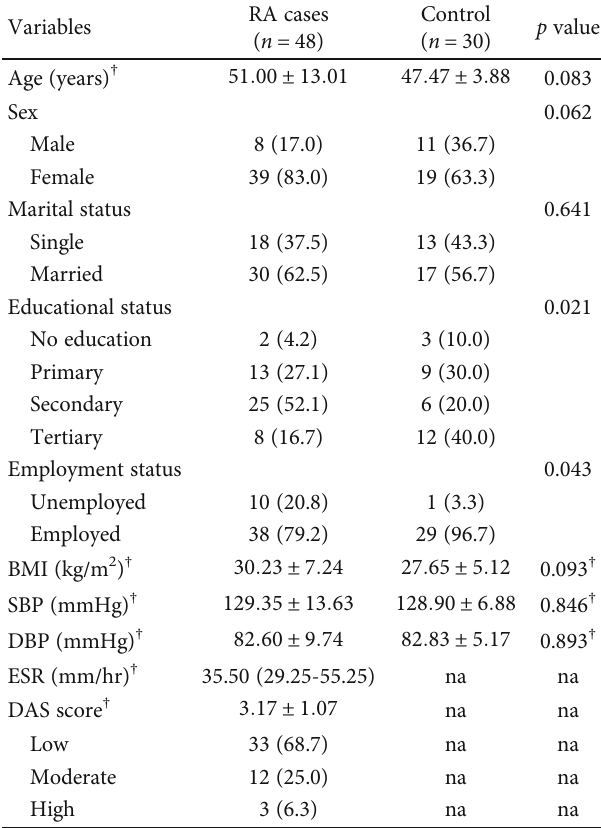
Table 1: Demographic and clinical characteristics of the study